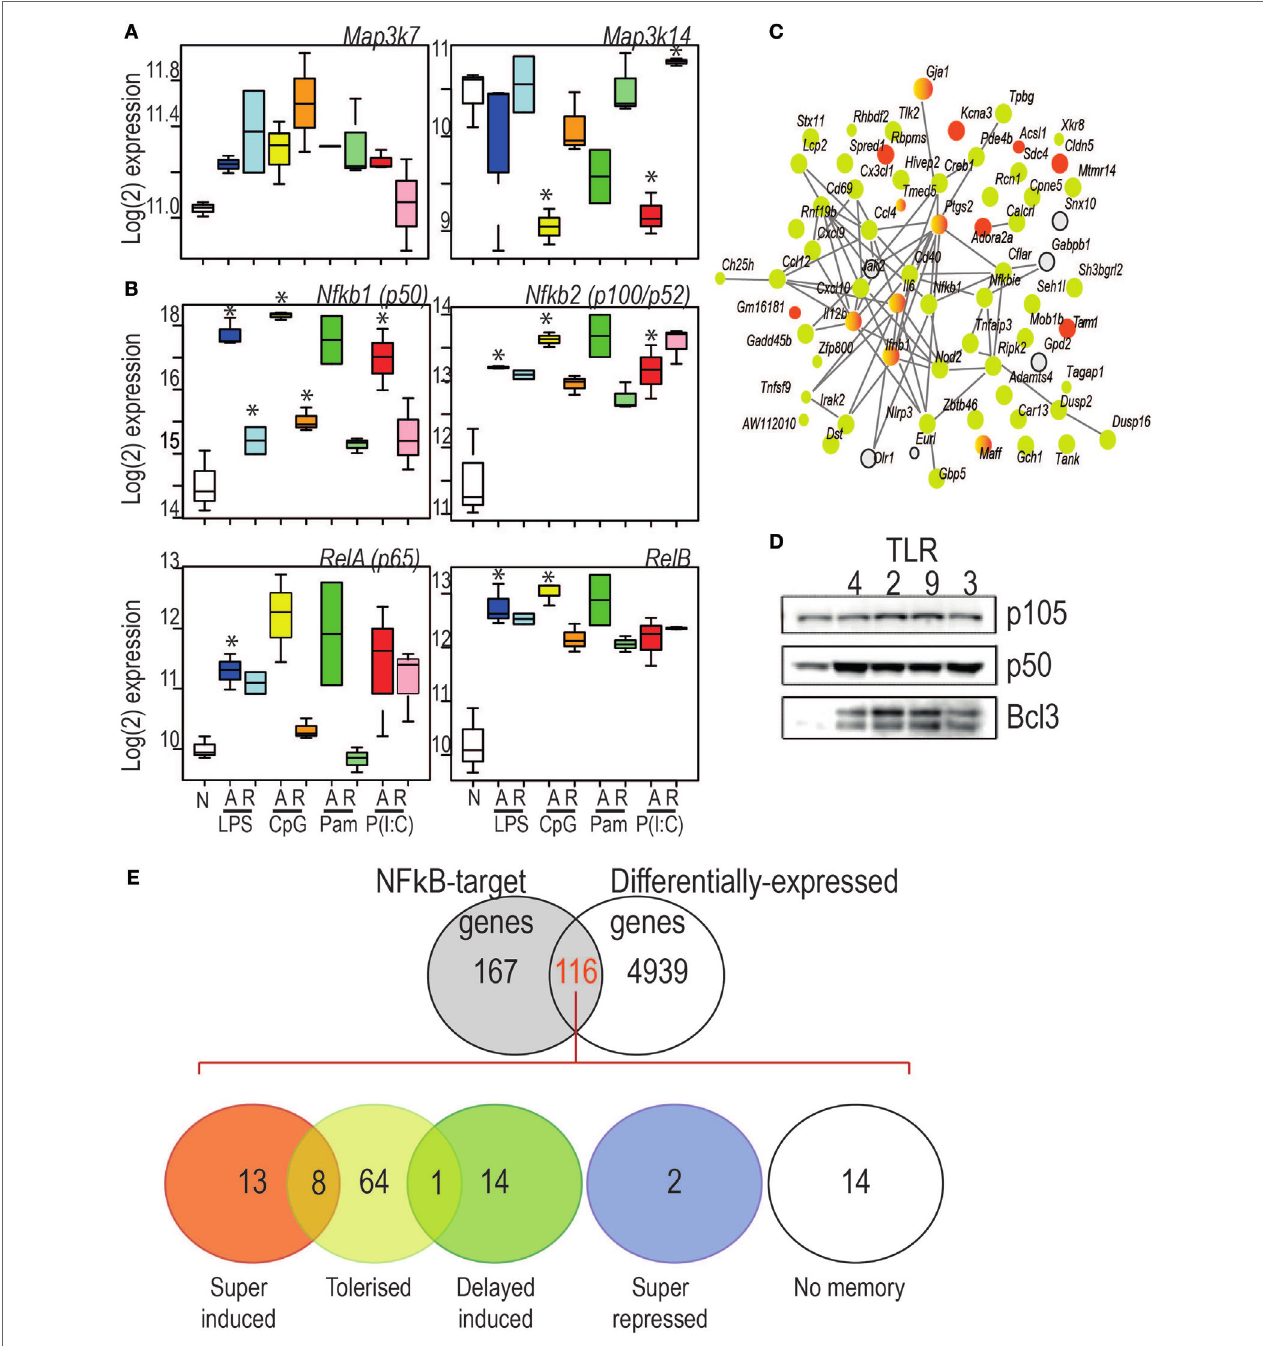
FigUre 7 | (a) Log 2 expression of two kinases central to the canonical (left) and non-canonical (right) NF- κ B pathways. (B) Key components of the canonical and non-canonical NF- κ B pathways exhibit different regulatory patterns. Y-axis: Log 2 expression. *indicates significant differential expression (adjusted p < 0.05). (c) StringDB protein–protein association network for the proteins encoded by the 70 genes commonly induced during acute responses by the four toll-like receptor ligands. Nodes: proteins. Edges protein–protein association. Colors: yellow: tolerized; red: super-induced; gray: no memory pattern. (D) Western Blot analysis of p105, p50, and BCL3 expression in cells stimulated for 24 h with ligand for TLR4, TLR2, TLR9, and TLR3 as indicated. (e) Characterization of differential expression and memory status of NF- κ B target genes. Figure 7E overlap between NF- κ B target genes and differentially expressed genes (adjusted p < 0.05, any acute infection). Number of genes per pattern is indicated in each colored circle. Circle overlaps show numbers of genes with both patterns, either due to multiple differently behaving probes, or ligand-specific memory pattern